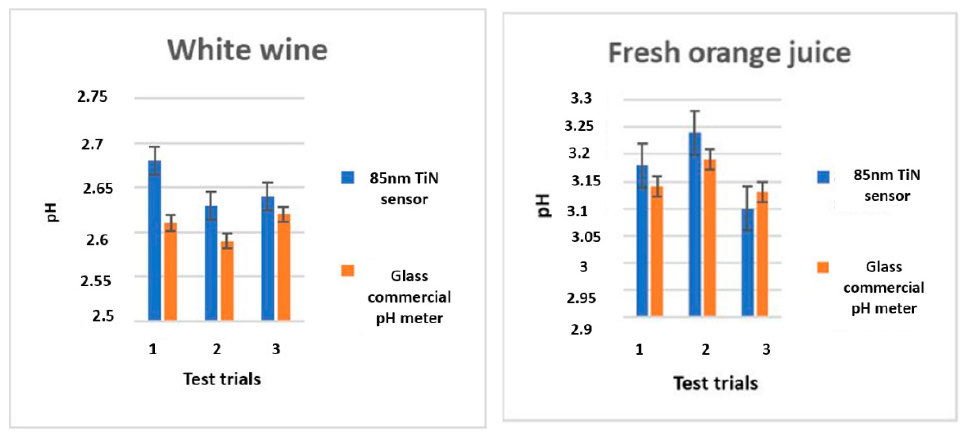
Figure 10. The pH values of 85 nm TiN cycled three times, and the pH values determined by a commercial pH meter in white wine and fresh orange juice matrices.